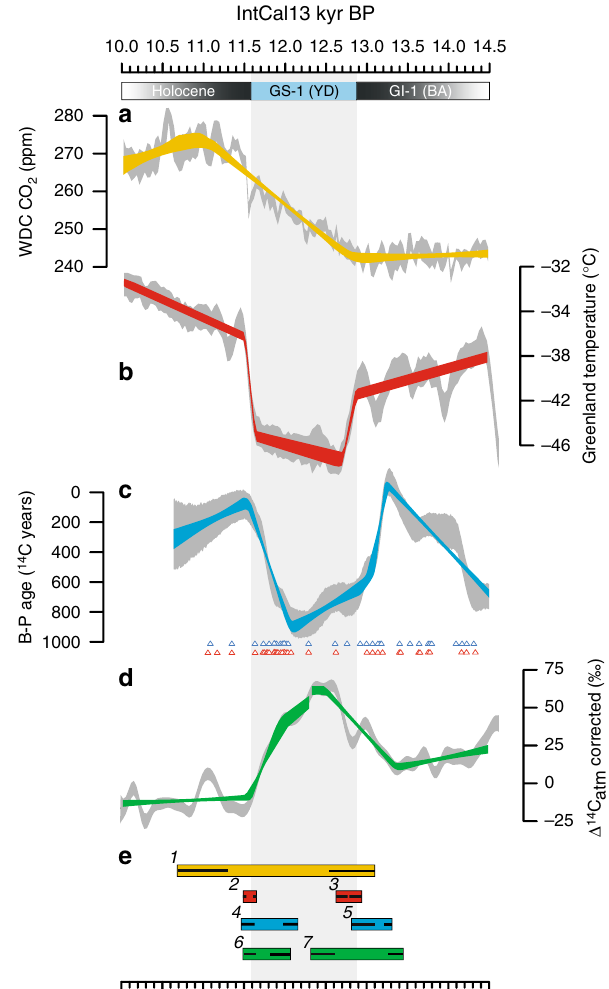
temperature (i.e., to within a few centuries) should not, therefore, be expected in numerical model simulations.